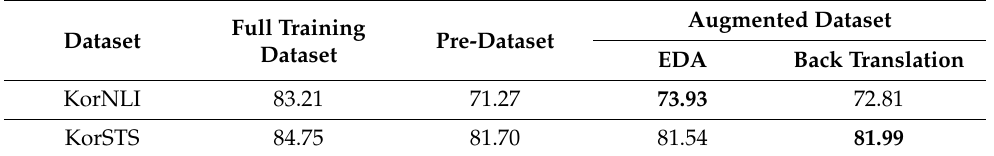
Table 3. Performance on downstream tasks of pre-trained ENLIPLE-v2: NLI, natural language inference (accuracy); STS, semantic textual similarity (Spearman).